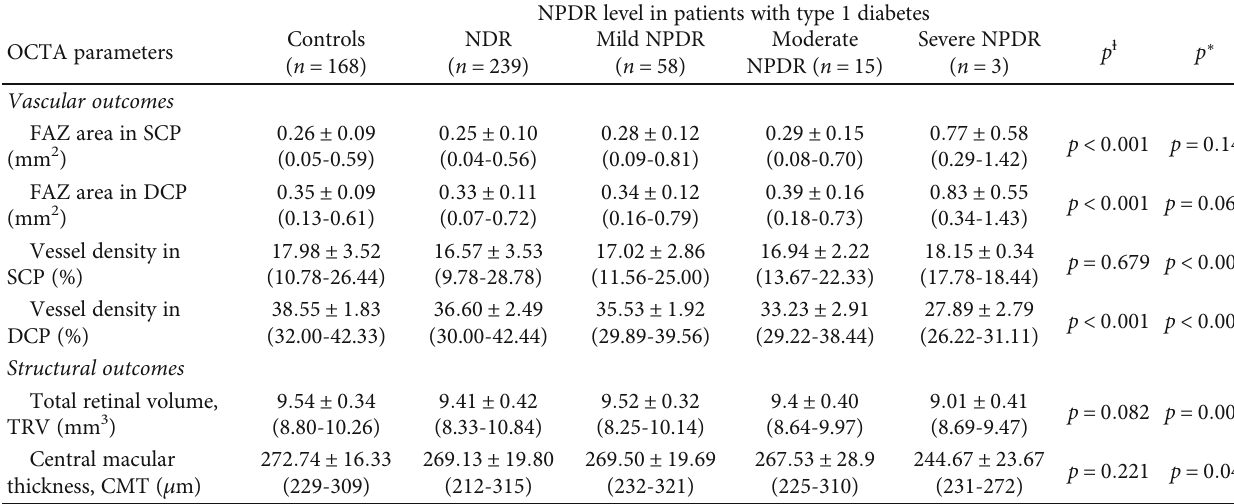
Table 2: Descriptive analysis of macular OCTA parameters in controls and patients with T1D with di ff erent levels of NPDR. NPDR level in patients with type 1 diabetes